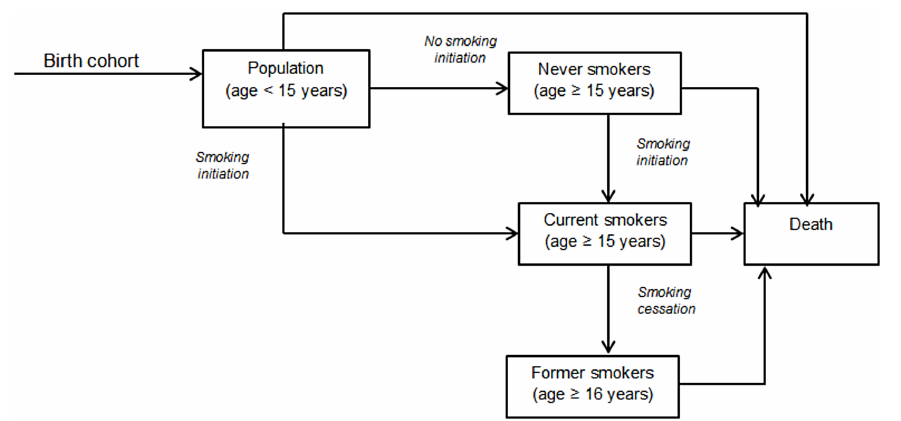
Fig 1. Overviewof the smoking prevalencemodel for the base year population.